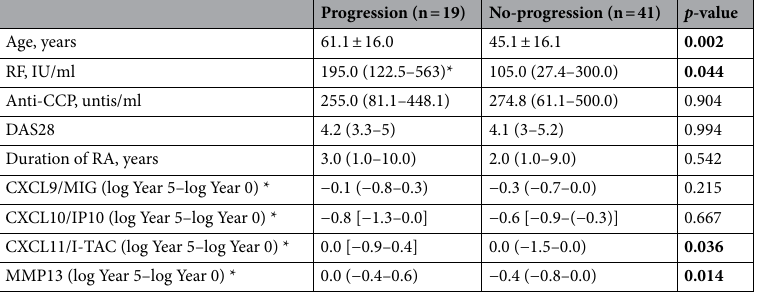
Table 3. Factors predicting radiographic progression in RA-ILD. * 56 patients had cytokine analysis at Year 5 (excludes n = 4 progressors who died prior to Year 5 serum collection). After normality testing (K-S test) for the nine indices, age conformed to a normal distribution. The actual values were presented as mean ± standard deviation. RF, anti-CCP, DSA28 and disease duration at baseline did not adhere to a normal distribution and were therefore converted by logarithm transformation and presented as median values (interquartile range). Changes in cytokine levels of CXCL11/I-TAC and MMP-13 from Year 0 to Year 5 were converted by logarithm transformation and expressed as (log Year 5—log Year 0). Significant differences were found between the progression and the no-progression groups for age, RF, CXCL11/I-TAC (log Year 5—log Year 0) and MMP13 (log Year 5—log Year 0). Other variables did not show statistically significant differences.